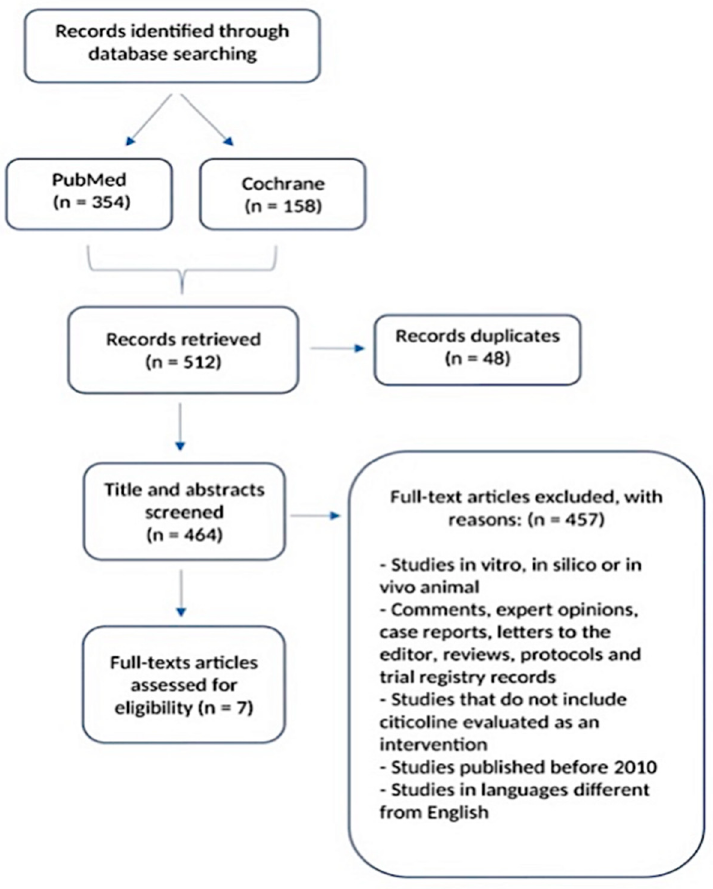
Figure 1 . PRISMA flow diagram illustrating the study selection process